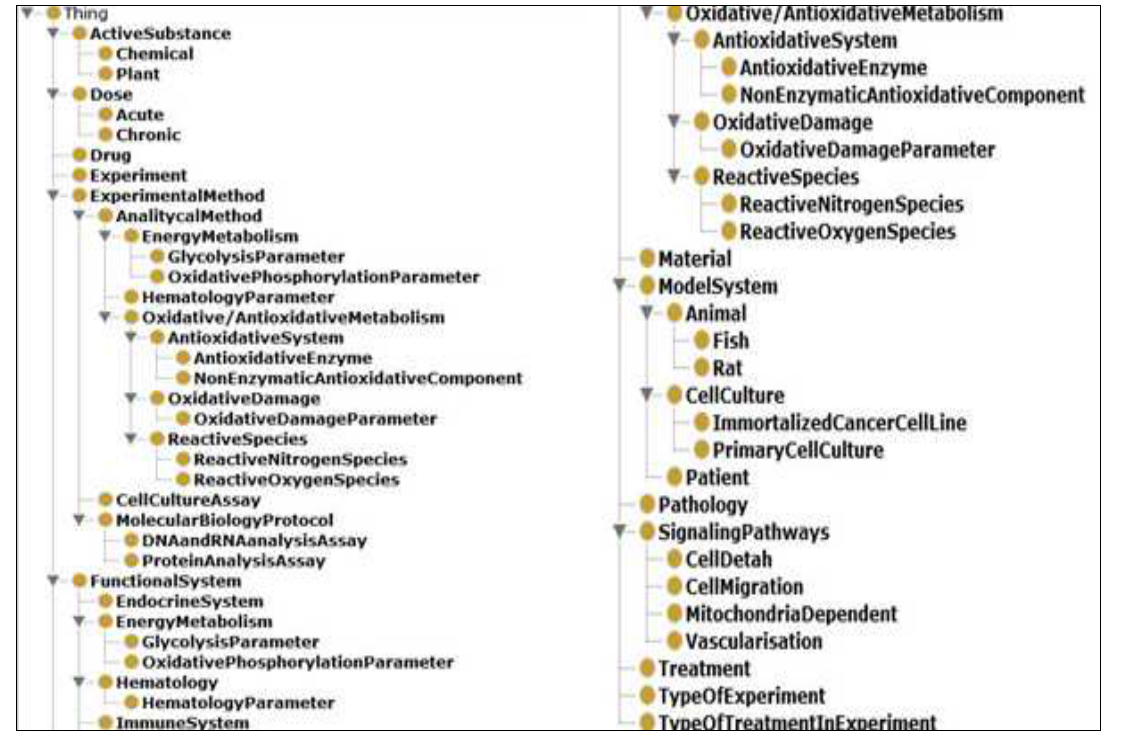
Figure 2. Class hierarchy for Experiment ontology in